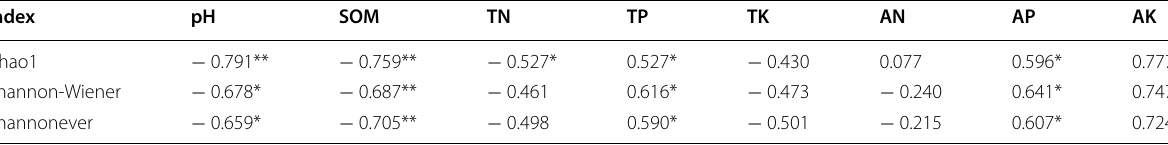
* indicate P < 0.05 ** indicate P <